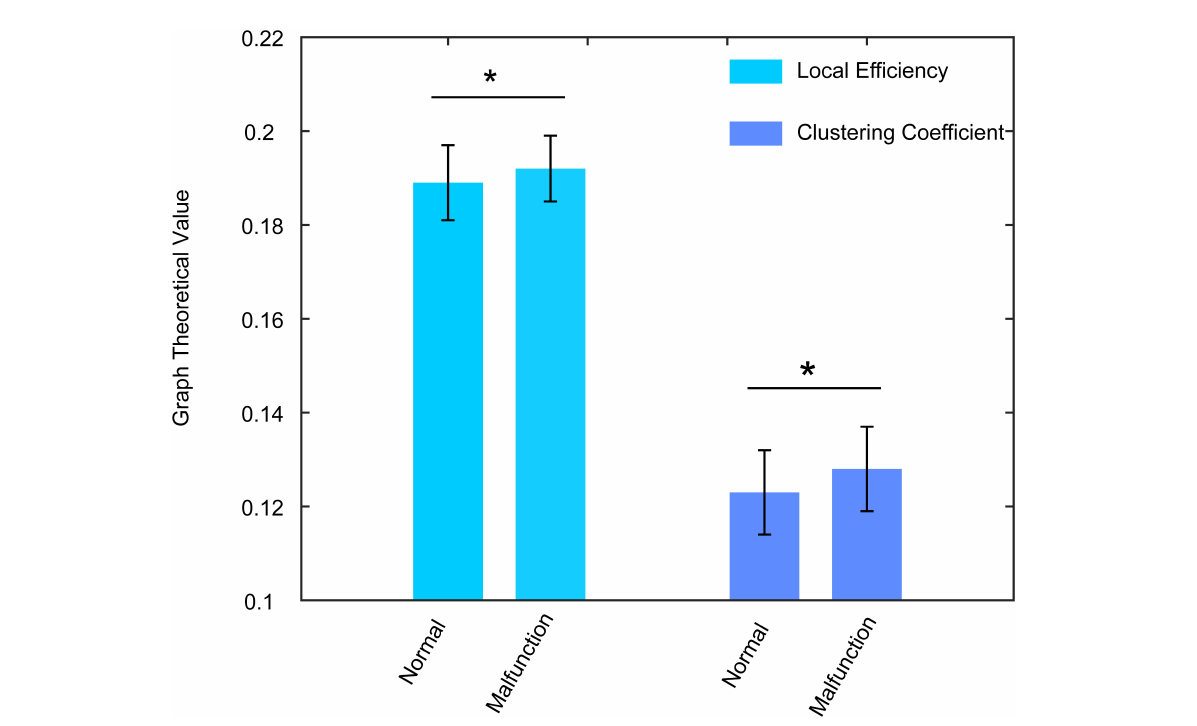
FIGURE5 The characteristic path length and global efficiency alterations between normal condition and malfunction condition in the TL condition. Both two indexes show significantly higher values in malfunction conditions. * p <